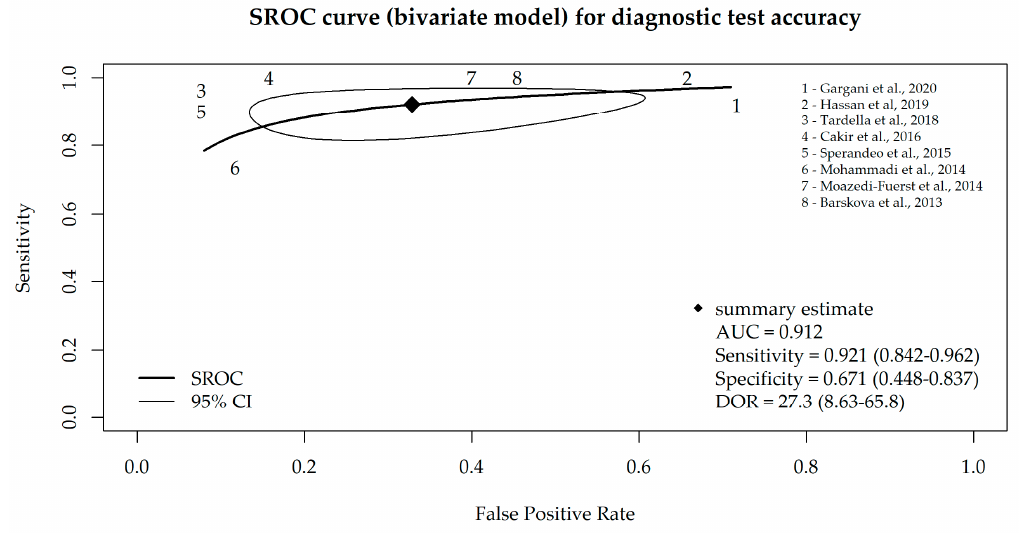
Figure 3. SROC curve for diagnostic test accuracy obtained from the bivariate meta-analysis model of LUS, based on eight studies that used B-lines as a criterion for ILD diagnosis